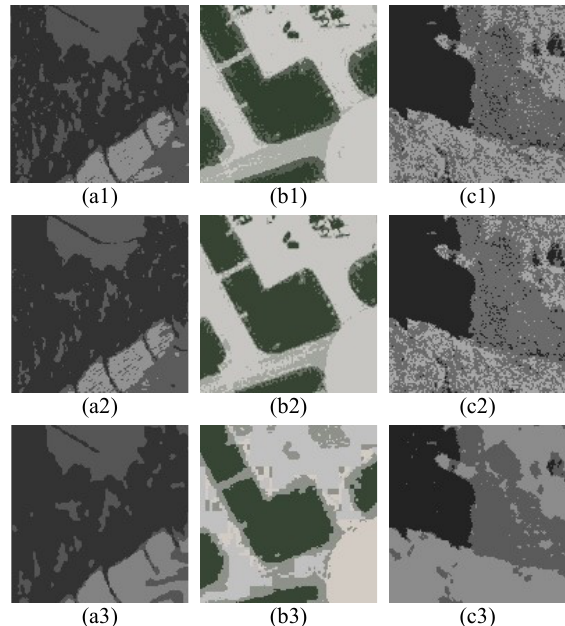
Figure 6. Segmentation results of remote sensing images with comparing algorithms.